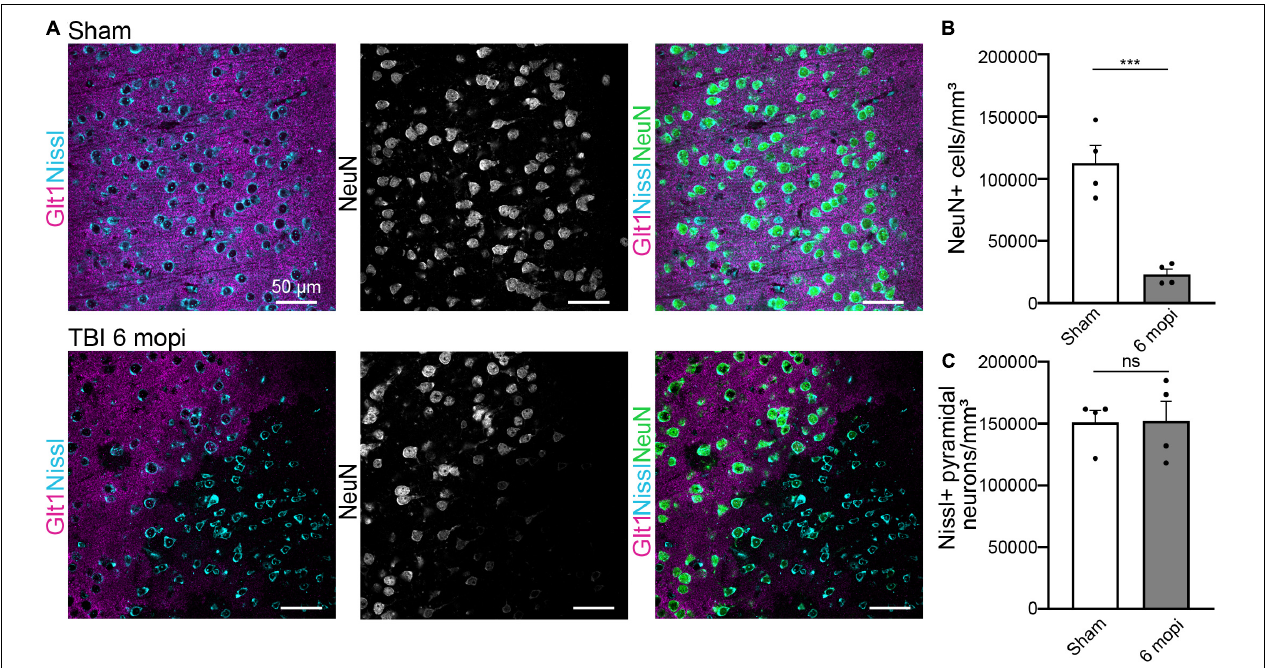
FIGURE 6 | Atypical NeuN expression is maintained 6 months after injury. (A) The reduction in atypical NeuN expression in atypical areas persisted up to 6 mopi, while Nissl continues to stain all NeuN expressing subtypes. Panels in the top row show Sham, and panels on the bottom row are TBI 6 mopi (Blue: Nissl, Magenta: Glt1, B&W: NeuN, Green: NeuN). (B) NeuN cell density (cell/mm 3 ) was measured in atypical areas 6 mopi and plotted per animal (Sham, 112,677 ± 14,024, n = 4; 6 mopi, 23,311 ± 4,056, n = 4). Two-tailed t -test: significant, p ≤ 0.001. (C) Nissl cell density (cell/mm 3 ) was measured in atypical areas 6 mopi and plotted per animal (Sham, 151,096 ± 9,742, n = 4; 6 mopi, 152,232 ± 16,018, n = 4). Two-tailed t -test: non-significant, p ≤ 0.9537. * p -value ≤ 0.05, ** p -value ≤ 0.01, *** p -value ≤ 0.001, **** p -value ≤